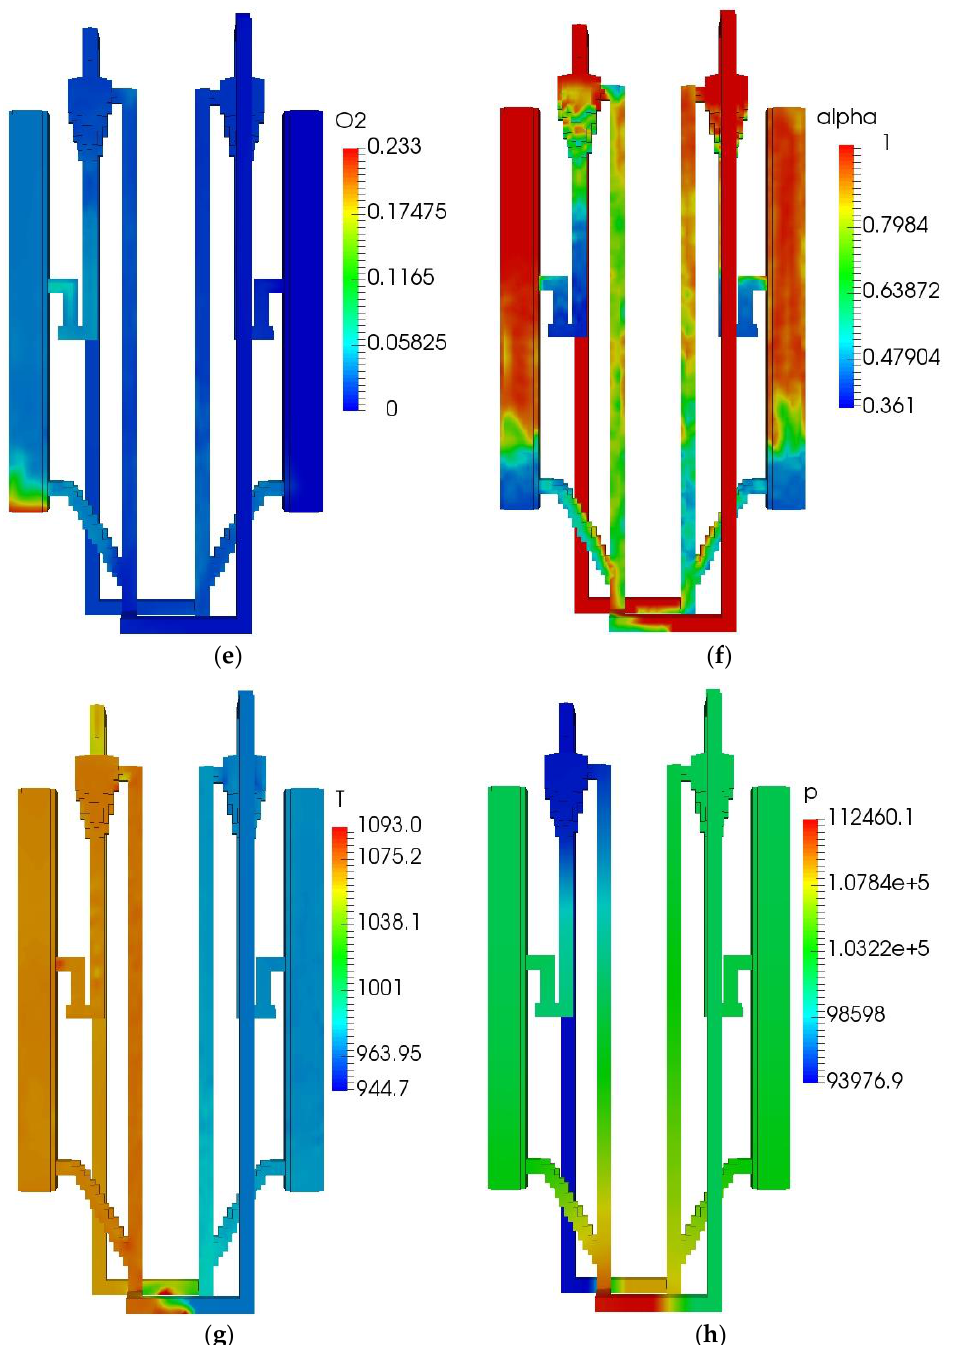
Figure 3. QFBG operation results. ( a ) H 2 mass fraction; ( b ) CH 4 mass fraction; ( c ) CO mass fraction; ( d ) CO 2 mass fraction; ( e ) O 2 mass fraction; ( f ) Voidage distribution; ( g ) Temperature distribution; ( h ) Static pressure distribution.